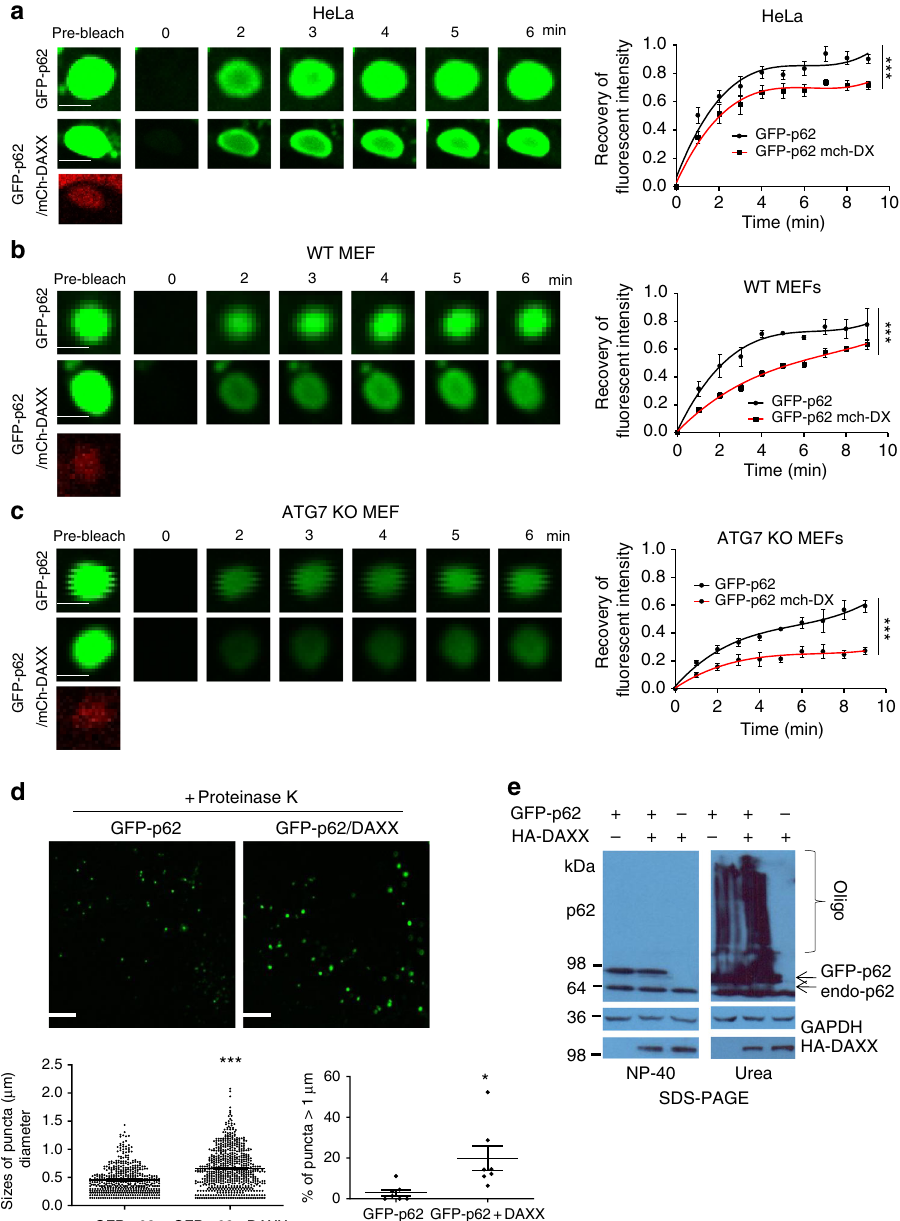
Fig. 3 DAXX induces p62 liquid phase condensation. a – c HeLa cells ( a ), wild-type (WT) mouse embryonic fi broblasts (MEFs) ( b ) or ATG7 KO MEFs ( c ) were transfected with GFP-p62 or GFP-p62/mCherry-DAXX. After 24 h, cells were subjected to live imaging and FRAP assays. n = 6 for each group ( a ), 7 for each group ( b ), 8 for each group ( c ) puncta from three independently plated wells. The data were plotted and analysed with Graphpad Prism V5 using nonlinear regression (curve fi t). Two-way ANOVA was used for statistical analysis. Data are shown as mean ± sem. *** P < 0.0001 (all). Bar: 2 µ m. d HeLa cells were transfected with GFP-p62/vecor or GFP-p62/Flag-DAXX (1:2). After 20 h, the cells were treated with proteinase K (50 µ g/ml) at 37 °C for 30 min. Images were acquired with a fl uorescence microscope. n = 475 (GFP-p62), 628 (GFP-p62 + DAXX) puncta from three independently plated wells ( fi rst); n = 7 independently plated samples for each group (second). Statistical analysis was performed with unpaired two-tailed T-tests. Data are shown as mean ± sem. *** P < 0.0001. * P = 0.0177. e Oligomerised p62 induced by DAXX is urea-soluble. GFP-p62/vector, GFP-p62/HA-DAXX or HA- DAXX/vector were transfected into HeLa cells. After 20 h, the cells were extracted in Buffer A with NP-40. The supernatants, and the pellets dissolved with Buffer A containing 8 M urea, were subjected to SDS-PAGE, and probed with anti-p62, and other antibodies as indicated. Oligo: